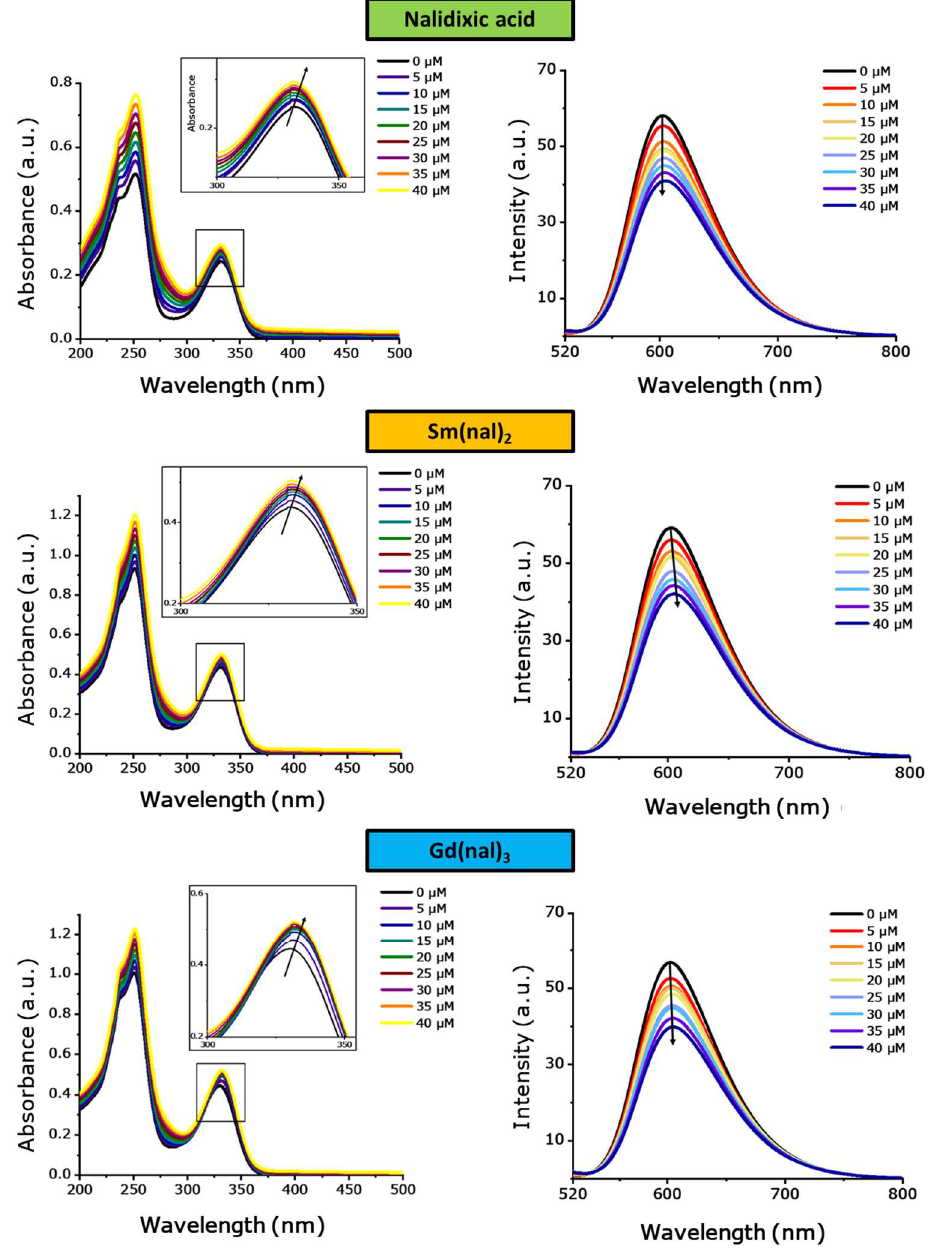
Figure 6. ( left ) Absorption spectra of nalidixic acid, Sm(nal) 2 and Gd(nal) 3 in the presence and absence of increasing amounts of DNA: [compound] = 20 μM; [DNA] = 0, 5, 10, 15, 20, 25, 30, 35, 40 μM. The arrow indicates the change in absorption upon increasing the DNA concentration. ( right ) Fluorescence spectra of the EB–DNA system in the absence and presence of increasing amounts of the tested compound. λ ex = 500 nm, [EB] = 2 μM, [DNA] = 10 μM, [compound] = 0, 5, 10, 15, 20, 25, 30, 35, 40 μM. The arrows indicate the changes in fluorescence intensities upon increasing the concentration of the tested compounds.